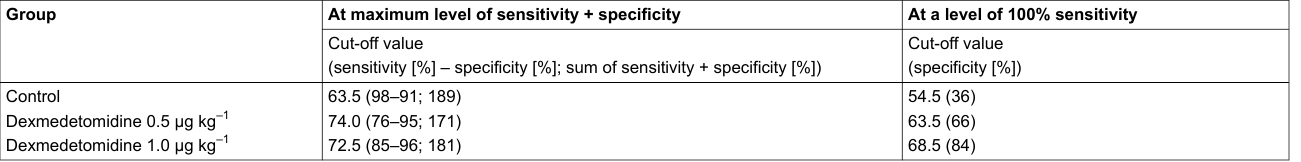
Table 5: Cut-off BIS values for detecting loss of consciousness at maximum level of sensitivity and specificity and at a level of 100% sensitivity. At maximum level of sensitivity + specificity At a level of 100% sensitivityGroup Cut-off value (sensitivity [%] – specificity [%]; sum of sensitivity + specificity [%])